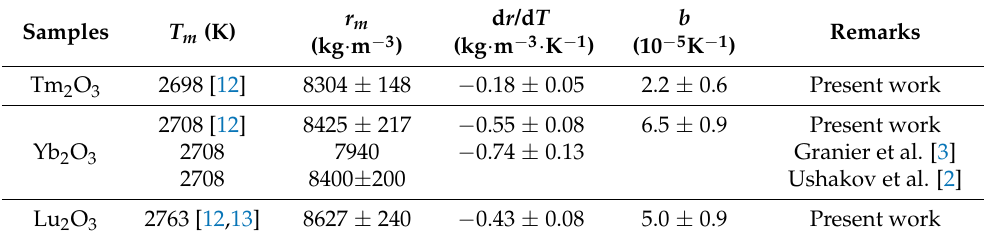
Table 3. Measured densities at the melting temperature ( ρ m ), temperature coefficients (d ρ /d T) ,